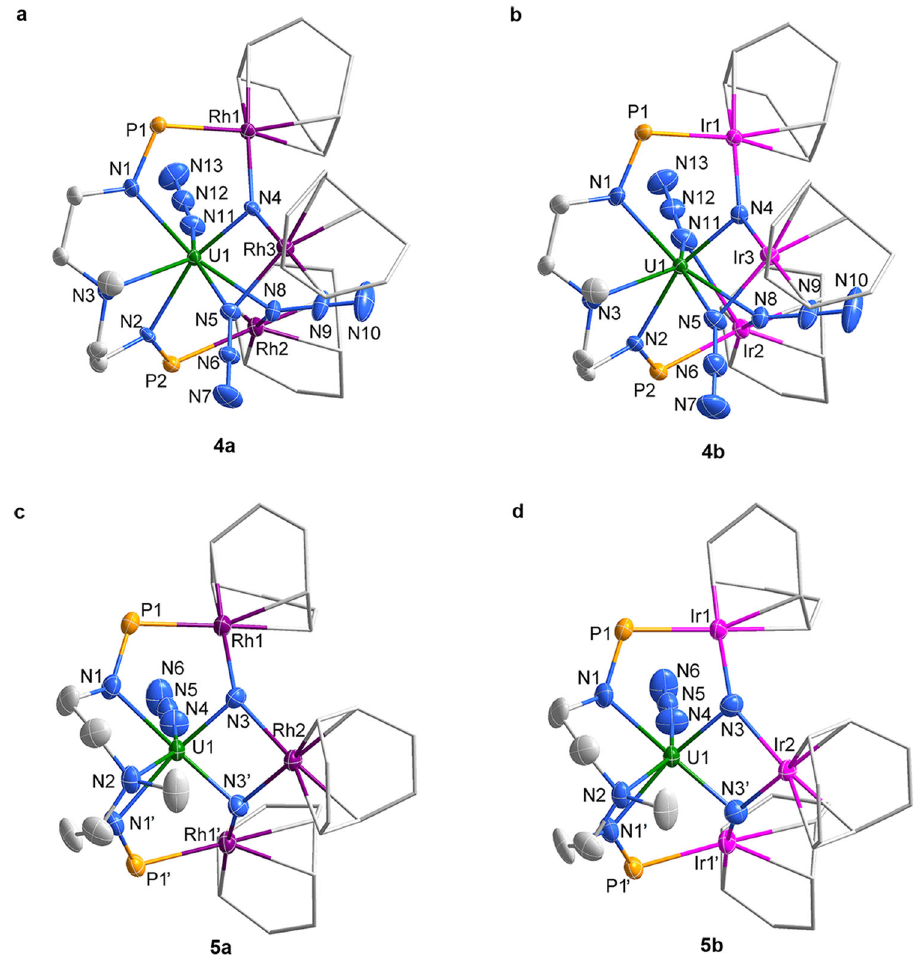
Fig. 4 Molecular structures of 4 and 5. a – d Solid-state structures of 4a ( a ), 4b ( b ), 5a ( c ), and 5b ( d ) by X-ray crystallography with 50% probability ellipsoids. Solvent molecules, hydrogen atoms, and the isopropyl moieties in P i Pr 2 are omitted for clarity. Uranium, green; rhodium, violet; Iridium, pink; phosphorus, orange; nitrogen, blue; and carbon,